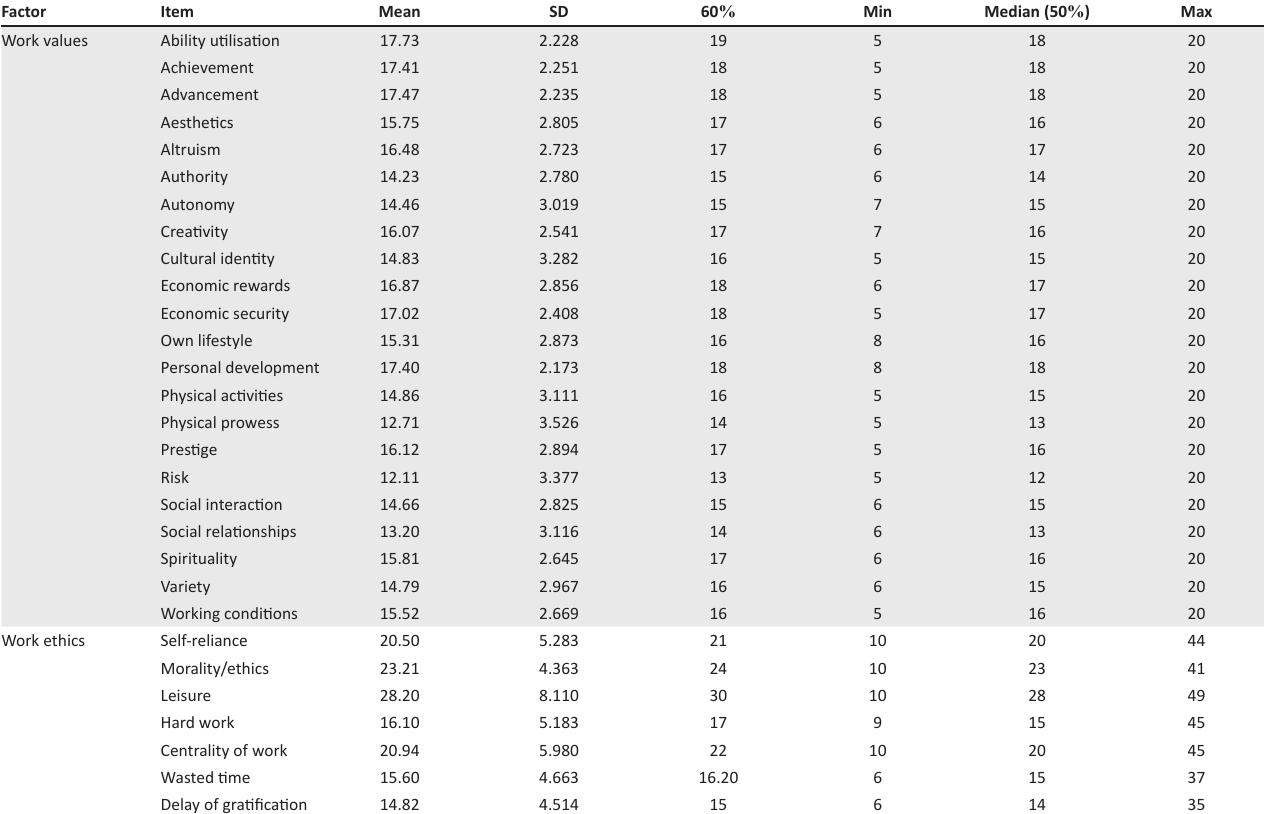
TABLE 3: Measures of central tendency and dispersion – work values and work ethics. Factor Item